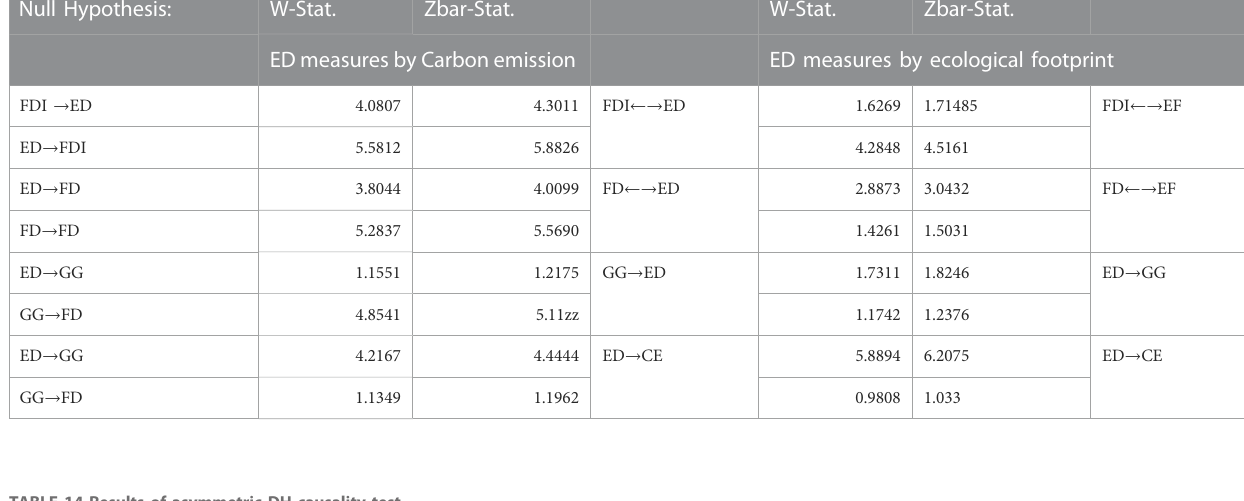
TABLE 14 Results of asymmetric DH causality test. Null Hypothesis: W-Stat. Zbar-Stat.